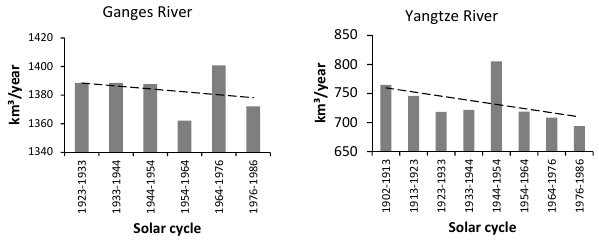
Figure 3. Ganges, Yangtze rivers discharge and